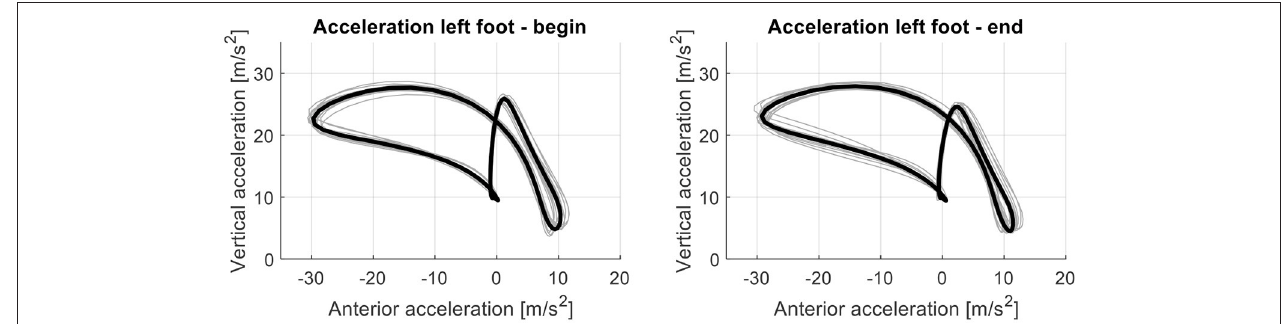
FIGURE 1 | The attractor (black line; mean of acceleration loops of all steps taken during 30m) and acceleration loops of all steps taken at the beginning (first 30m; left graph) and end (last 30m; right graph) of the 6MWT (gray lines) for the left foot exemplary in one healthy subject.